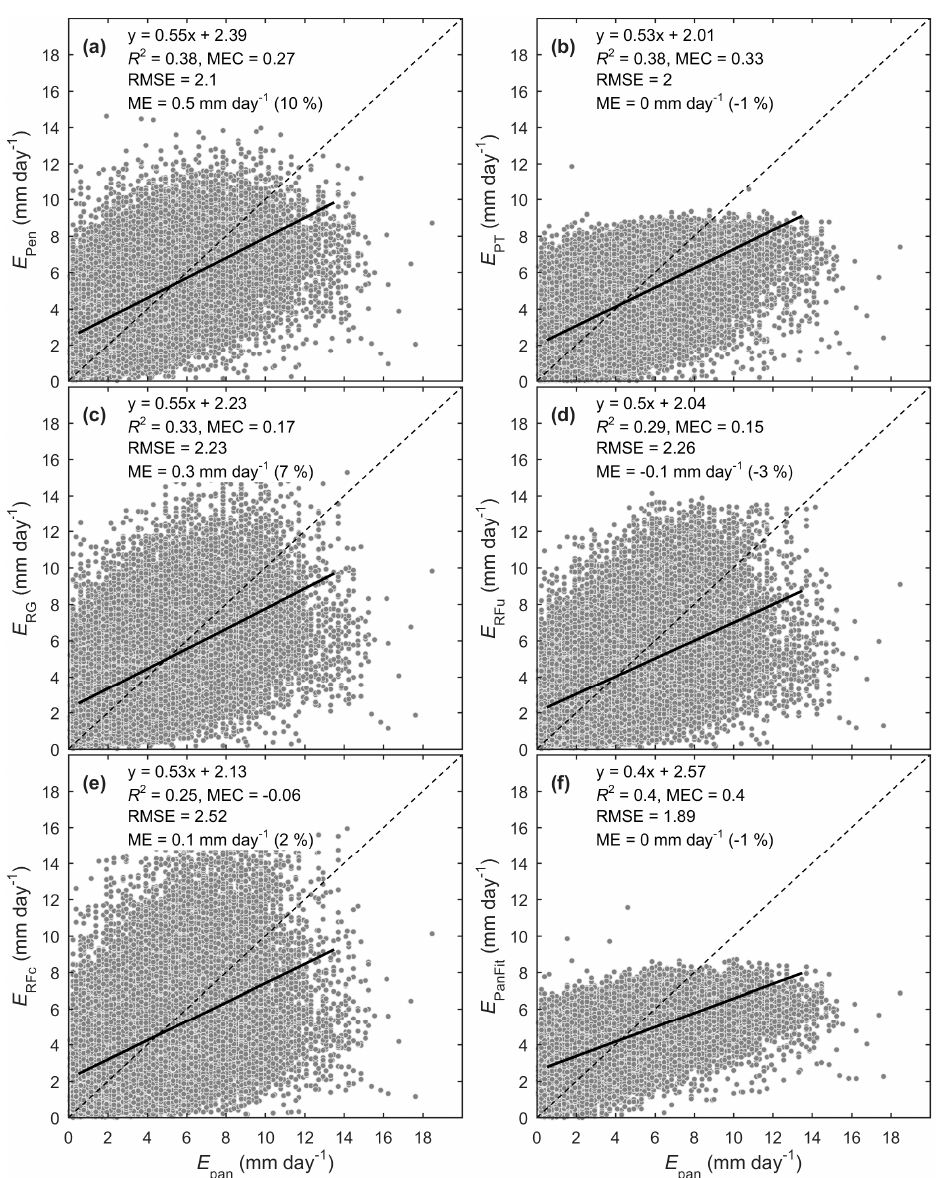
Figure 2. Comparison between observations of daily total pan evaporation ( E Pan ) (after applying the pan coefficient of 0.77) and models of potential evaporation based on: ( a ) Penman’s model ( E Pen ); ( b ) the Priestley–Taylor model ( E PT ); ( c ) reference rate for grassland based on the Penman–Monteith model ( d ) reference rate for forests canopies that are moderately coupled to the atmosphere ( E RFu ); ( e ) reference rates for forest canopies that are well coupled to the atmosphere ( E RFc ); ( f ) linear mixed-effects model fit to daily pan evaporation measurements ( E PanFit ). Linear curves indicate the ordinary least squares fits. Statistics include: coefficient of determination ( R 2 ), model efficiency coefficient (MEC, values of 0.0 or <0.0 indicate equivalent, or less predictive power than applying the mean of observations, respectively, while a value of 1.0 indicates a perfect predictor), root mean squared error (RMSE, mm·day − 1 ), and mean error (ME, mm·day − 1 or %).